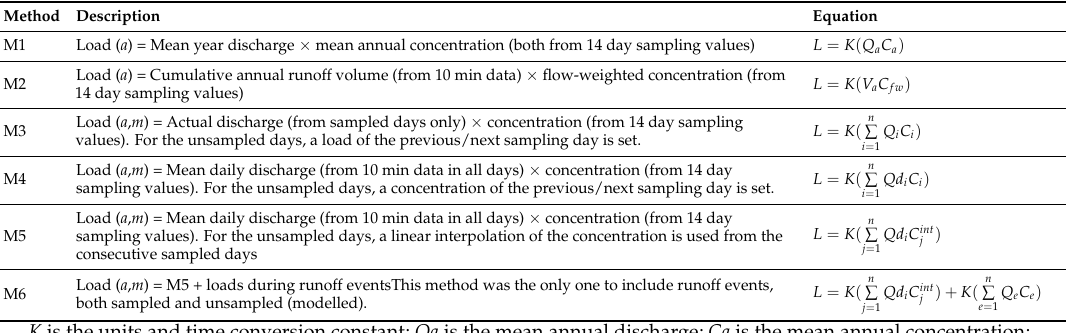
Table 2. The load assessment methods employed and compared in this